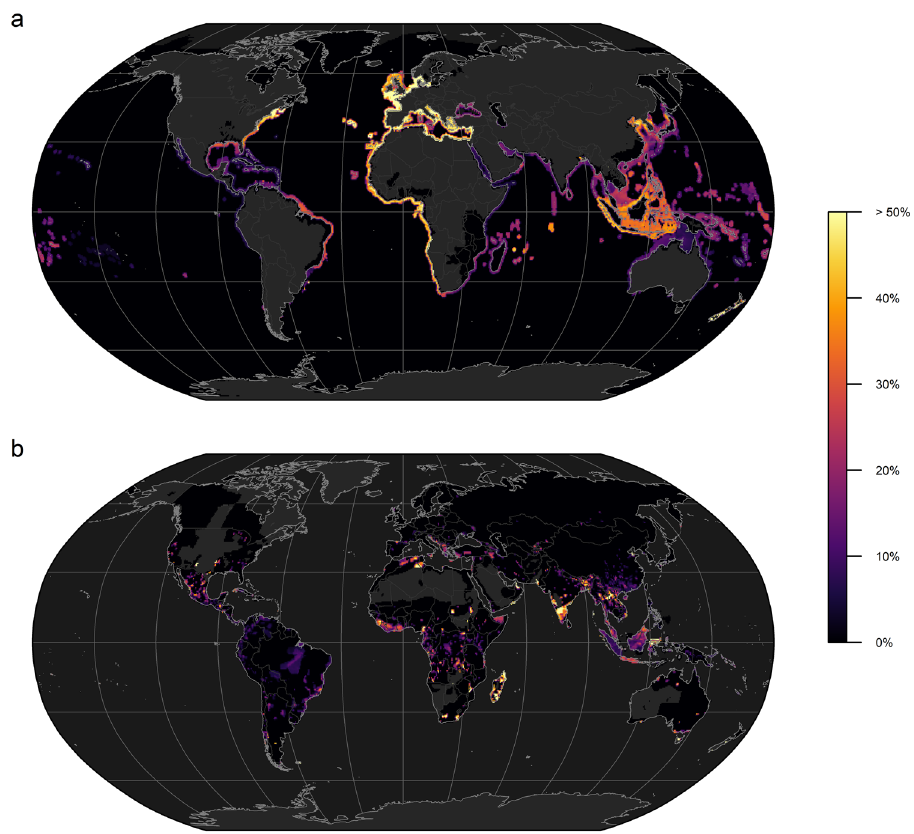
Fig. 2 Potentially threatened fraction of data de fi cient species. Fraction of Data De fi cient species ( n = 7699, IUCN Version 2020-3) predicted to be threatened by extinction for marine ( a ) and non-marine species ( b ) according to our machine learning classi fi